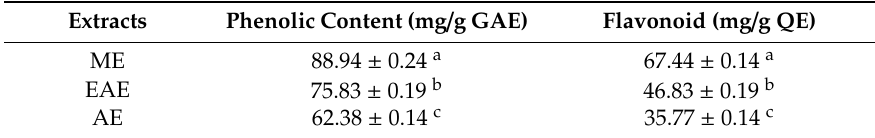
Table 1. Total phenolic and flavonoid